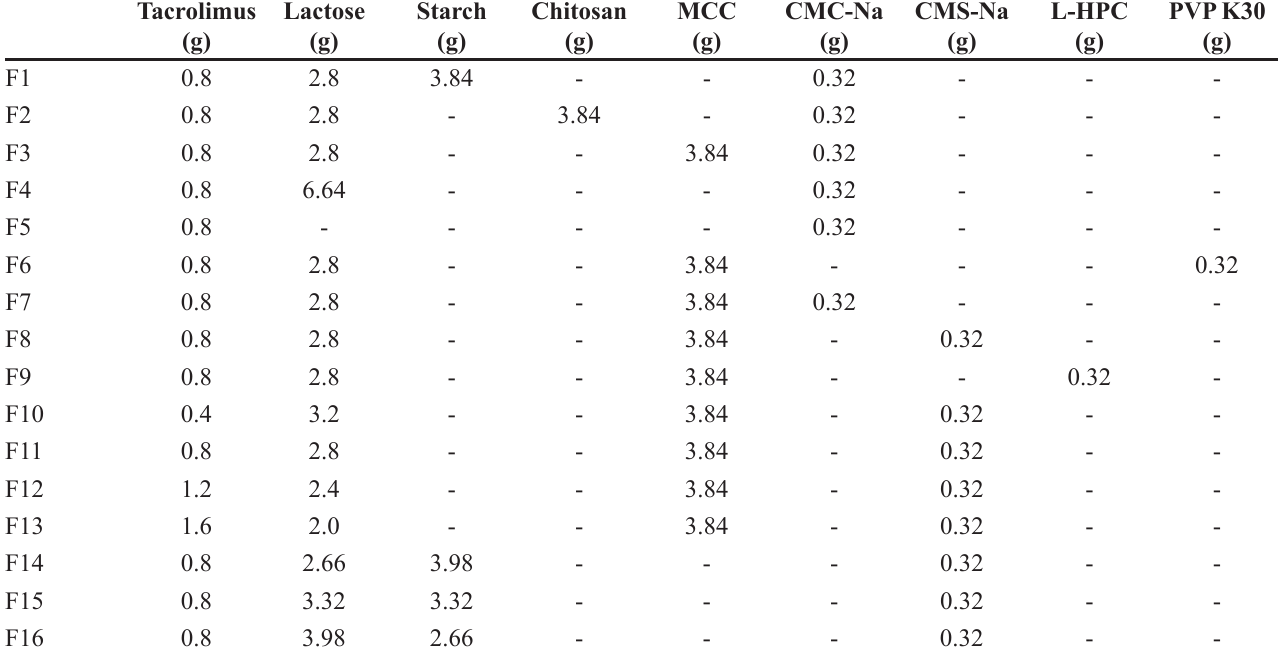
TABLE I - Composition of